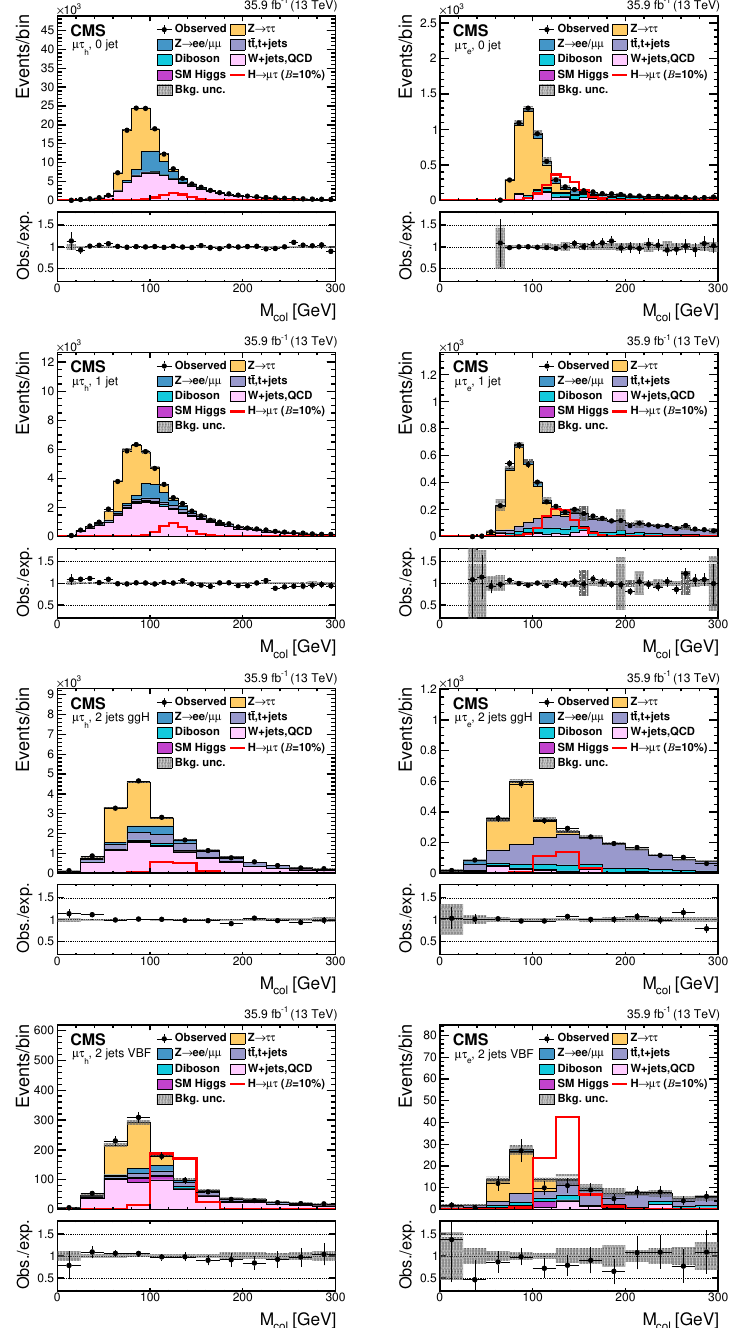
Figure 5 . Distribution of the collinear mass M col for the H ! (cid:22)(cid:28) process in M col (cid:12)t analysis, in di(cid:11)erent channels and categories compared to the signal and background estimation. The back- ground is normalized to the best (cid:12)t values from the signal plus background (cid:12)t while the overlaid simulated signal corresponds to B (H ! (cid:22)(cid:28) ) = 5%. The bottom panel in each plot shows the ratio between the observed data and the (cid:12)tted background. The left column of plots corresponds to the H ! (cid:22)(cid:28) h categories, from 0-jets ((cid:12)rst row) to 2-jets VBF (fourth row). The right one to their H ! (cid:22)(cid:28) e